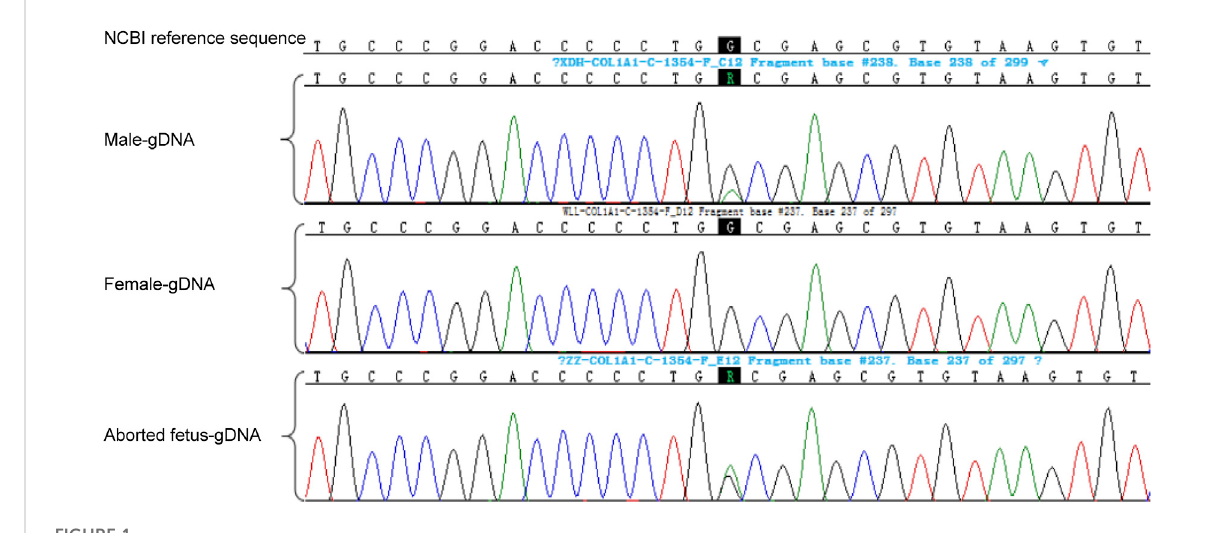
FIGURE 1 Validation of the mutation locus in the